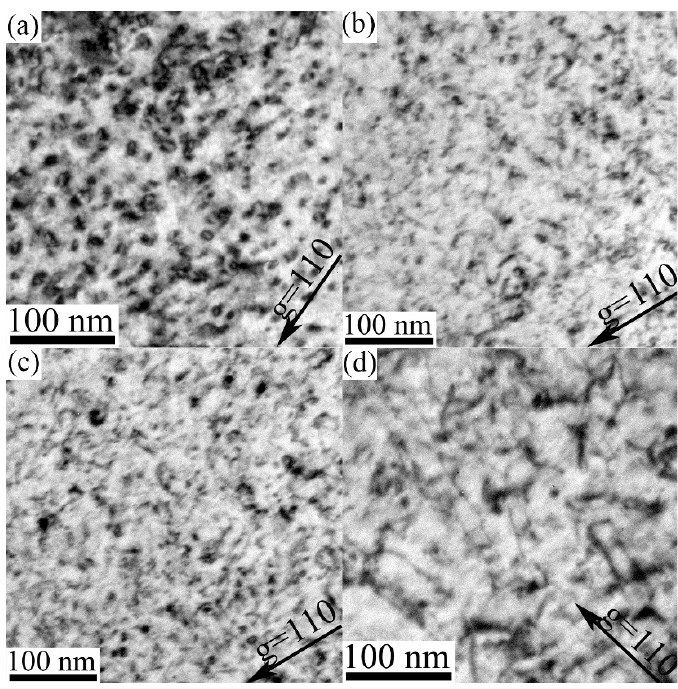
Figure 3. Bright field TEM micrographs of FeCrAl alloy in the 500–700 nm depth under the condition of [001] pole, g = − 110, the damage dose is ( a ) 1.0 dpa ( b ) 2.5 dpa, ( c ) 5.0 dpa, ( d ) 10.0 dpa.